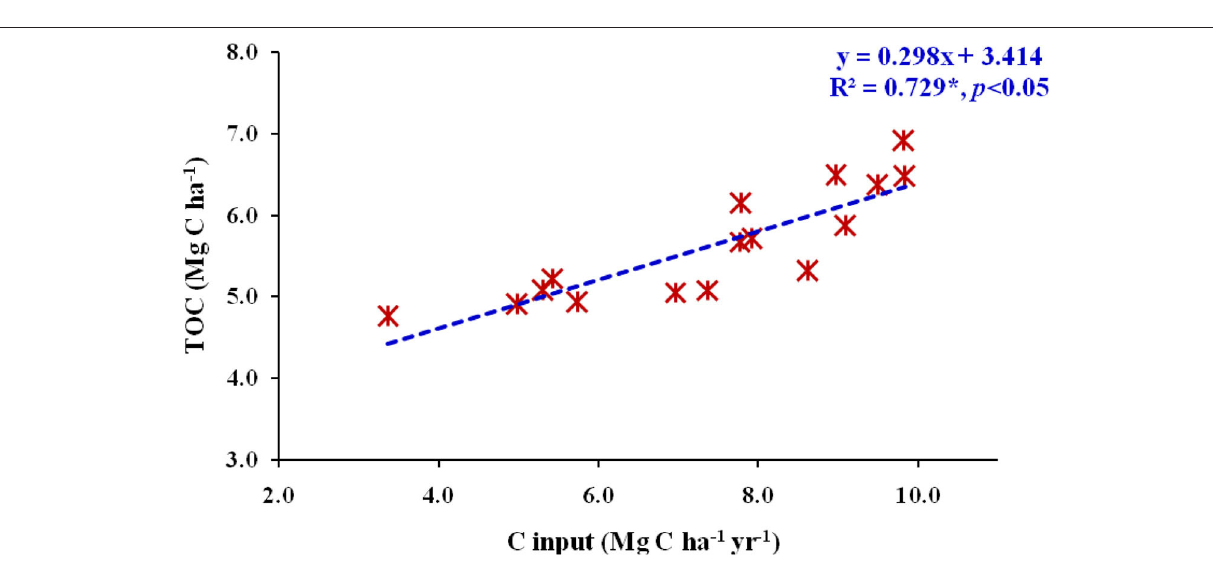
with RS 0 N 90 . Average across the treatments, TOC stocks were ∼ 27.8% higher in the surface, compared with the sub-surface soil layer. Figure 4 illustrates the relationship